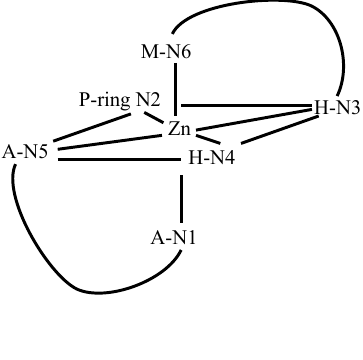
Figure 2. Schematic drawing of the Zn(II)-coordination site in Zn(II)BLM proposed by Akkerman et al.